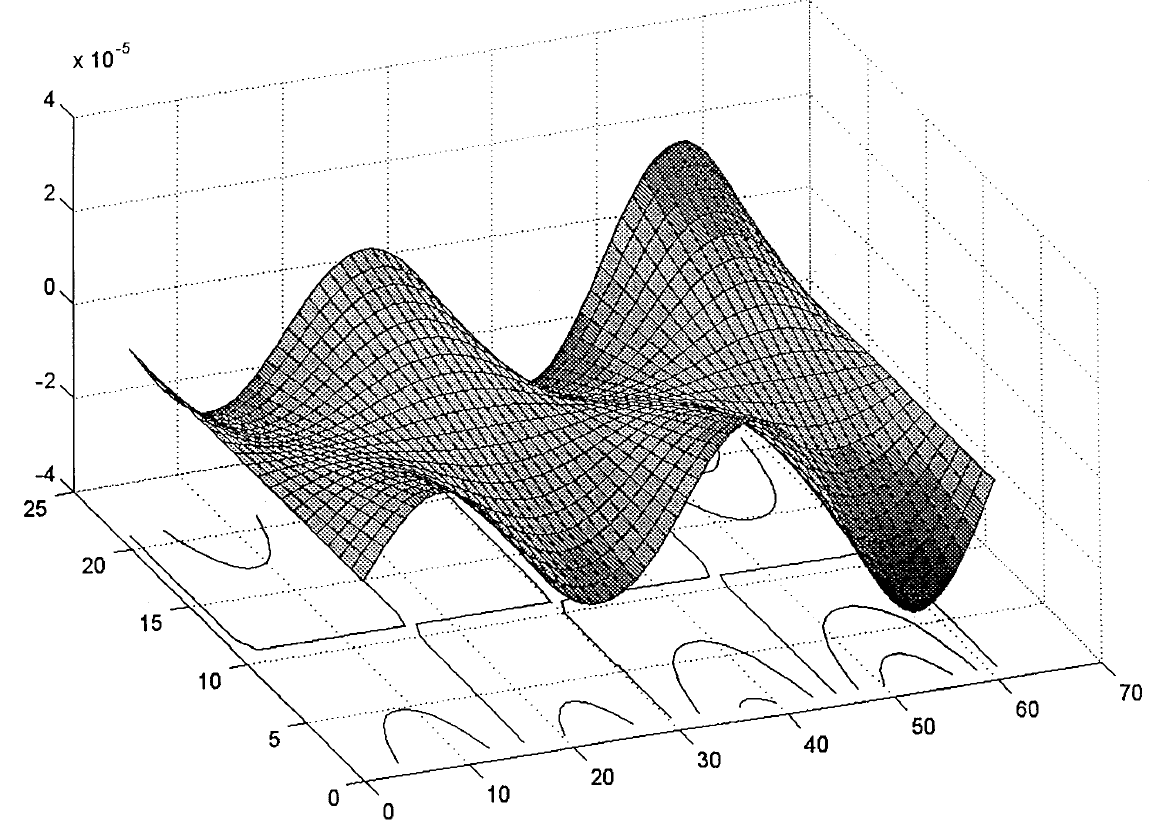
Fig. 12. Fourth mode shape of 4-span deck, φ 1 = φ 3 = φ 4 = 1 . 0 , φ 2 = 1 . 1